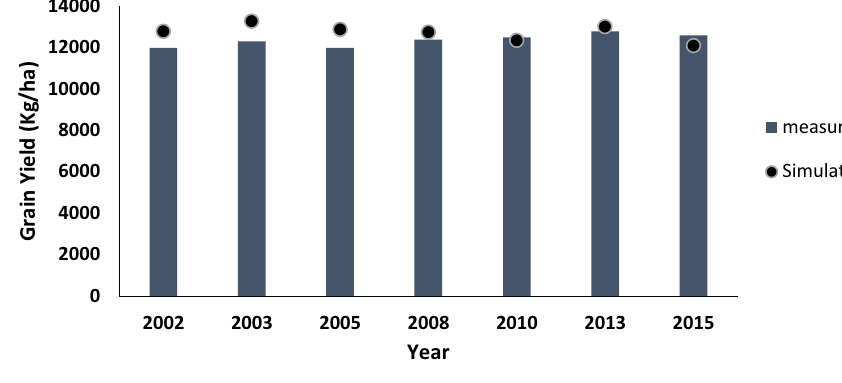
Fig. 5 The average of simulated grain yield and measured yield at farms of best maize producers in the region